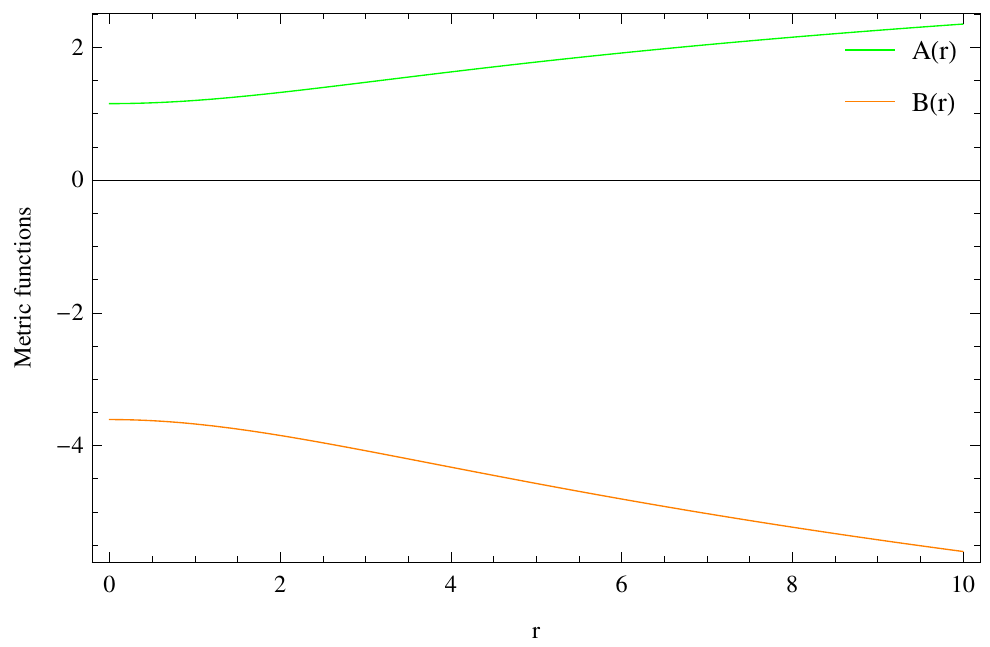
Figure 16. The metric functions are plotted against the radial parameter r with the values of the arbitrary constants ω = − 1/3, λ = − 0.1, C 4 = 0.001, C 5 = 10, C 6 =